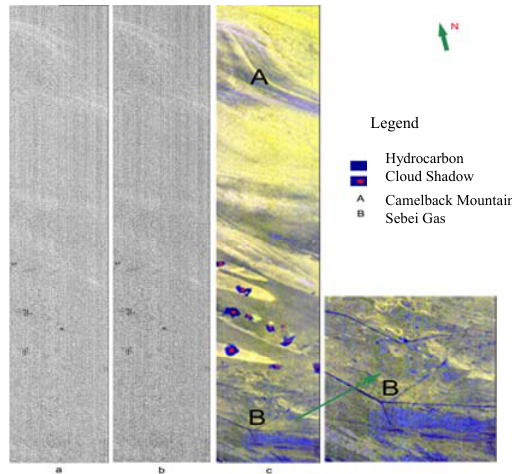
Figure 2. Extraction of Hydrocarbon